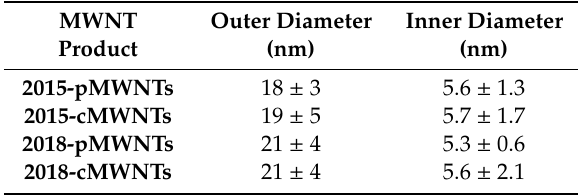
Table 4. TEM analyses of pMWNT and cMWNT